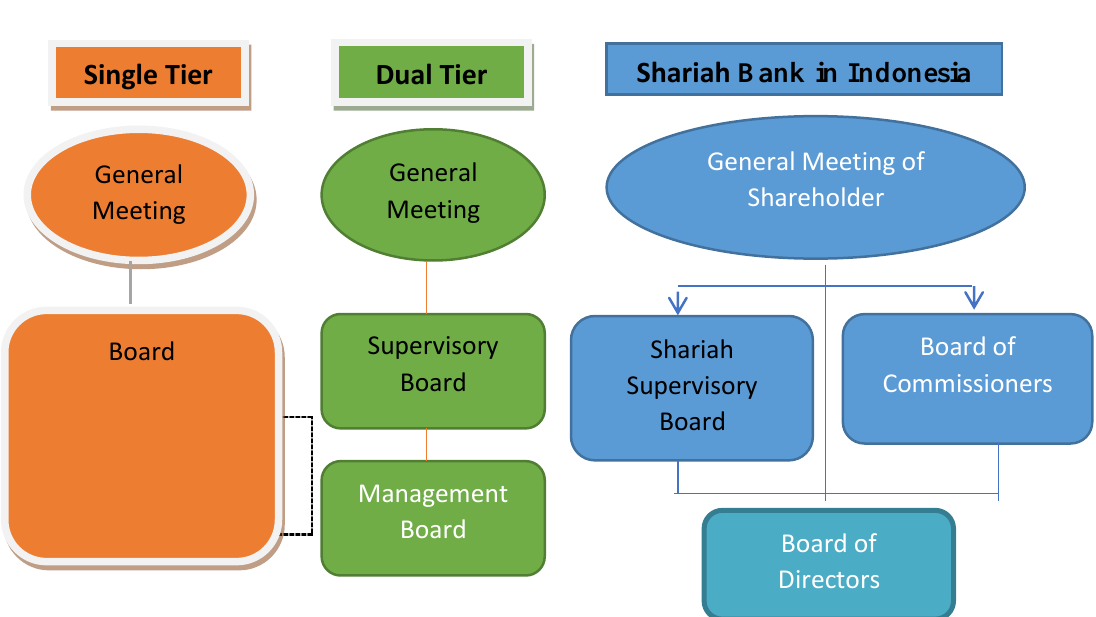
Fig. 1. Comparison of corporate governance of single tier, dual tier, and Shariah Banks in